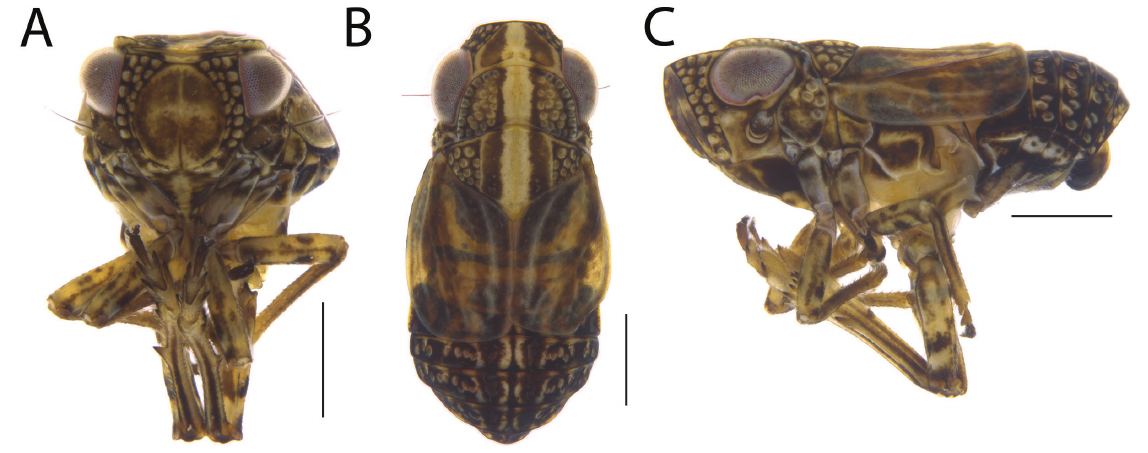
Fig. 24. Habitus of Protrocha punctatosa sp. nov. A–C . Holotype, ♂ (INHS). A . Frontal view. B . Dorsal view. C . Lateral view. Scale bars = 0.5